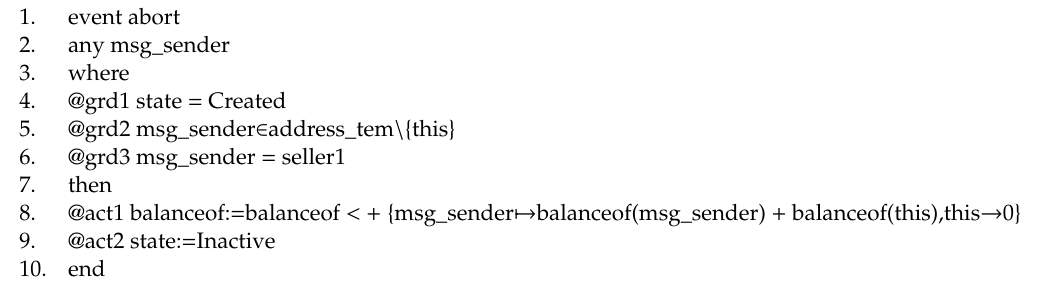
Table 2. Event “abort” of the Event-B model.